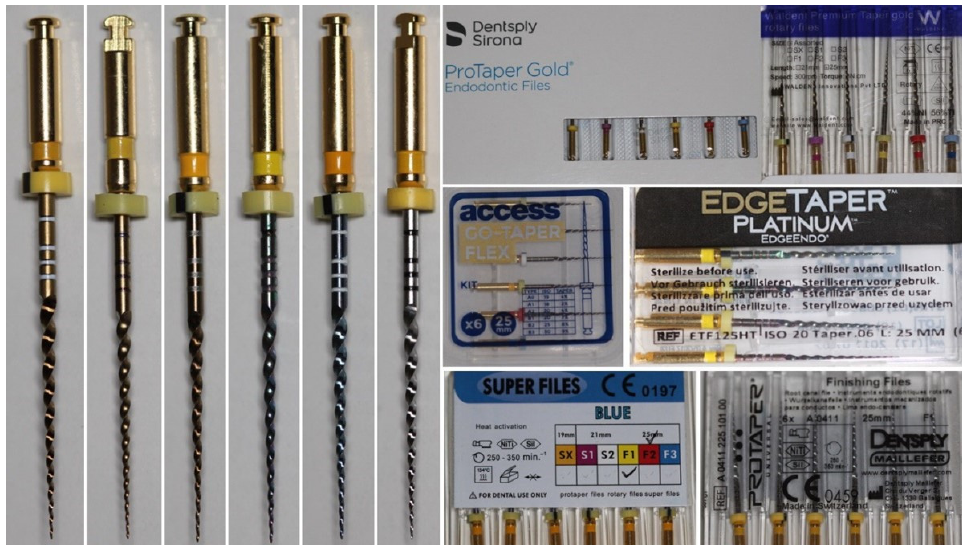
Figure 1. Macroscopic images of the 6 tested instruments (from left to right: ProTaper Gold, Premium Taper Gold, Go-Taper Flex, EdgeTaper Platinum, Super Files Blue and ProTaper Universal) with their respective labelled packing boxes.